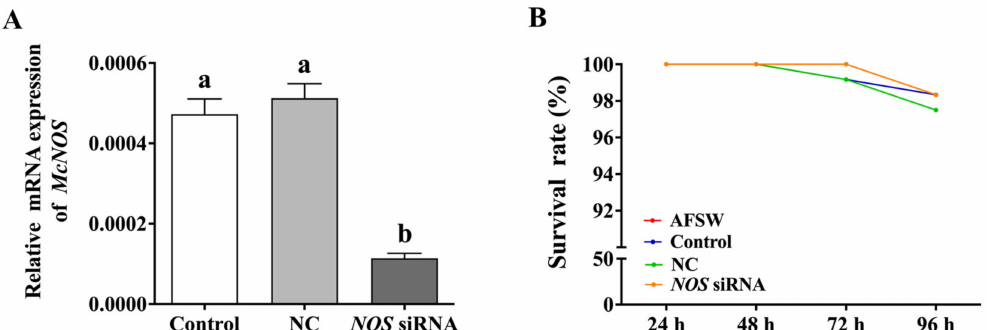
Figure 5. NOS mRNA expression and the larval survival rate after the knockdown of NOS expression. ( A ) McNOS mRNA expression in the larvae after NOS siRNA transfection for 48 h. ( B ) Larval survival rates at different timepoints after NOS siRNA transfection. Values represent mean ± SEM ( n = 800), and bars with different letters indicate significant differences ( p < 0.05). Control: the larvae were untreated, NC: the larvae were transfected with 1.2 µ g non-target gene siRNA, NOS siRNA: the larvae were transfected with 1.2 µ g McNOS